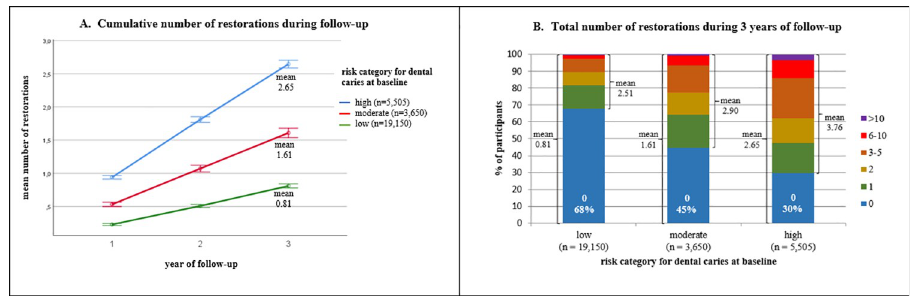
Fig 2. Number of restorations during follow-up. (A) Cumulative mean number of new restorations after 1, 2 and 3 years of follow-up per risk category for dental caries with error bars for the 95% confidence interval. (B) Distribution of the total number of new restorations per participant during 3 years of follow-up per risk category for dental caries at baseline.